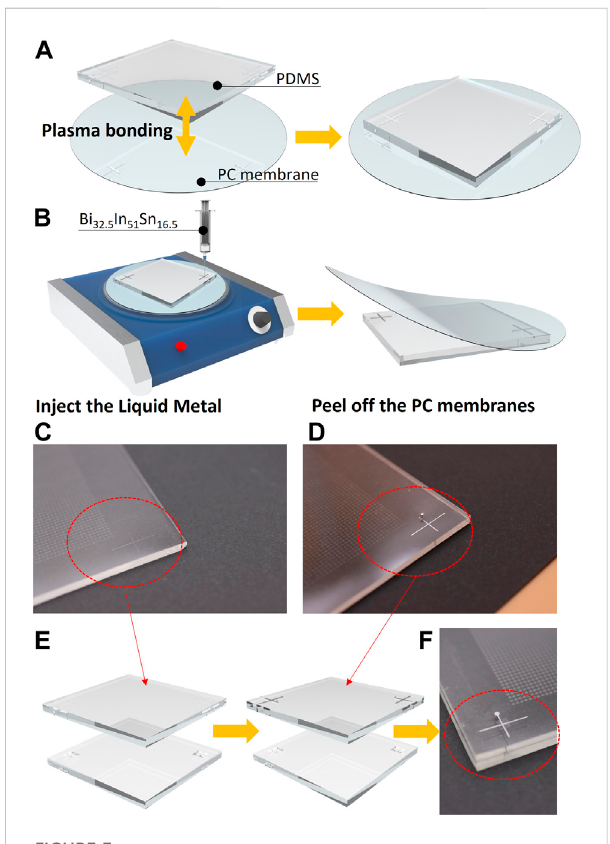
FIGURE 3 (A) Brief process of plasma bonding the PC membrane with the PDMS chip. (B) Brief process of producing liquid metal guidelines. (C) and (D) Comparison of liquid metal auxiliary wire before and after production. (E) Diagram of fabrication process and alignment processofupperandlowerliquidmetalwires. (F) Localtopviewofthe auxiliary liquid metal